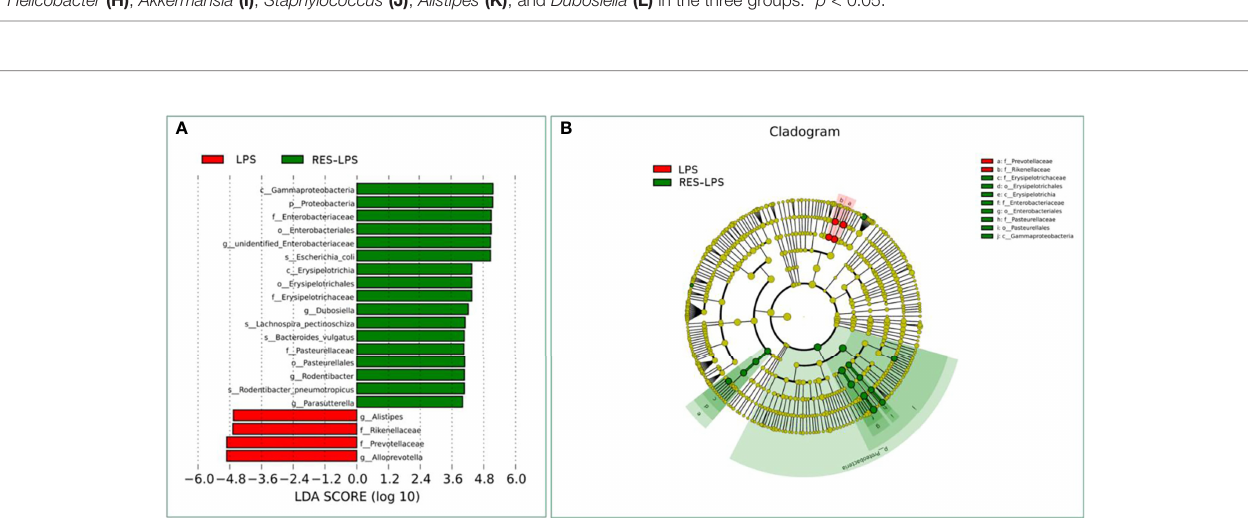
FIGURE 5 | Computational LDA (A) score and LEfSe (B) analysis comparing LPS and RES-LPS